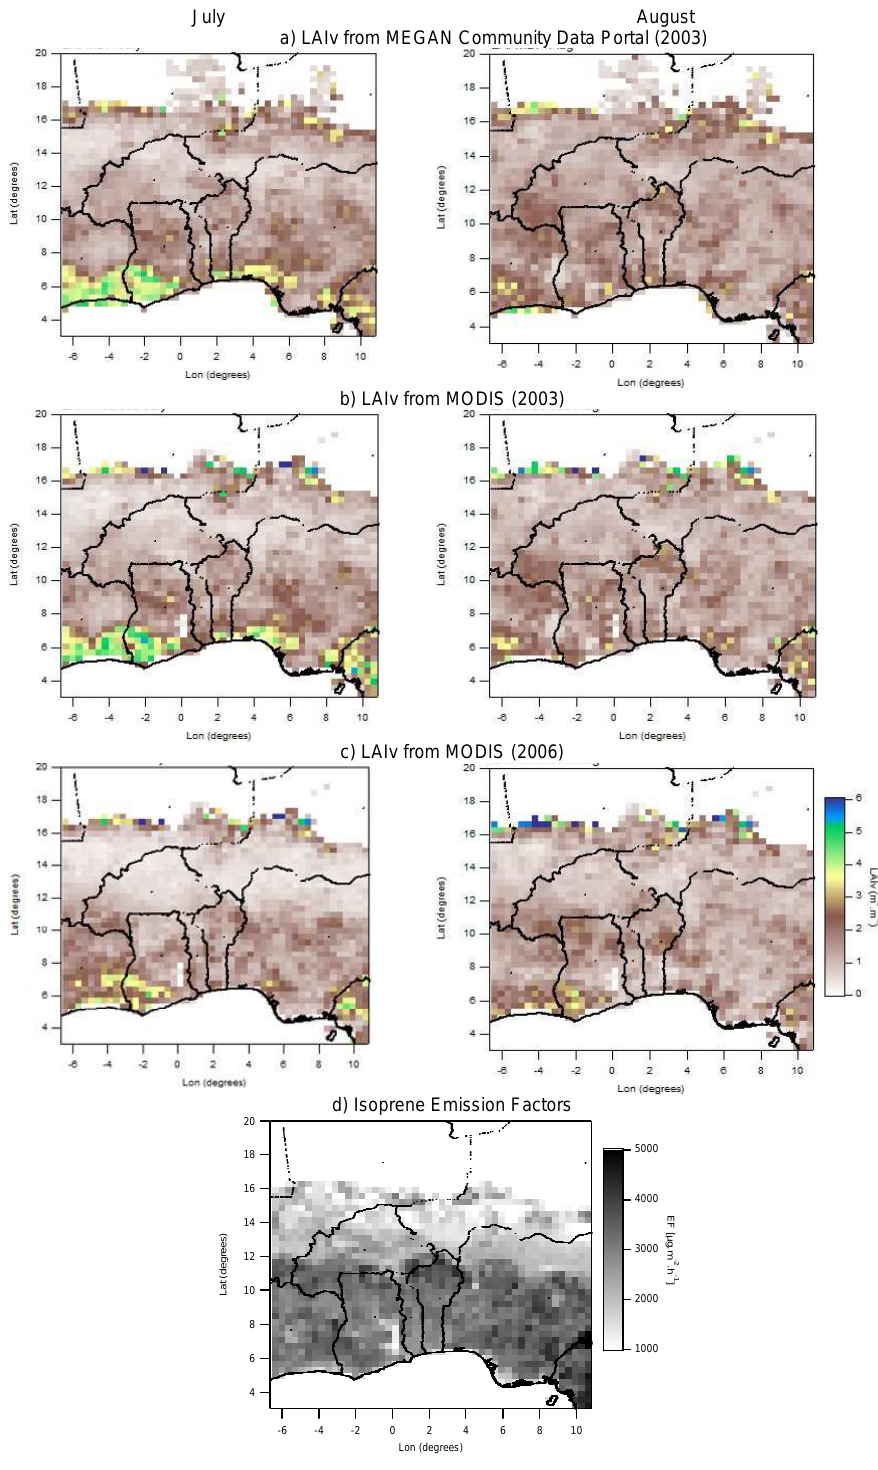
Fig. 3. Spatial distribution of the three different sets of LAIv data MCDP (2003) (a) , MODIS 2003 (b) , MODIS 2006 (c) , and the isoprene Figure 3 – Spatial distribution of the three different sets of LAIv data MCDP (2003) (a), MODIS emission factors for the 40km horizontal resolution domain (d) 2003 (b), MODIS 2006 (c), and the isoprene emission factors for the 40 km horizontal resolution domain (d).